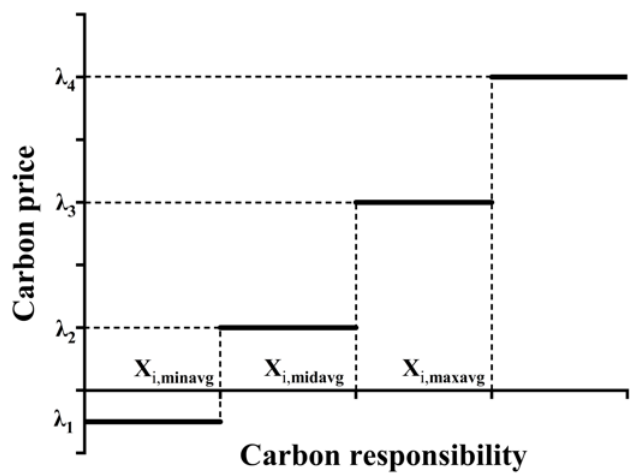
Figure 3. The schematic diagram of the ladder-type carbon price.